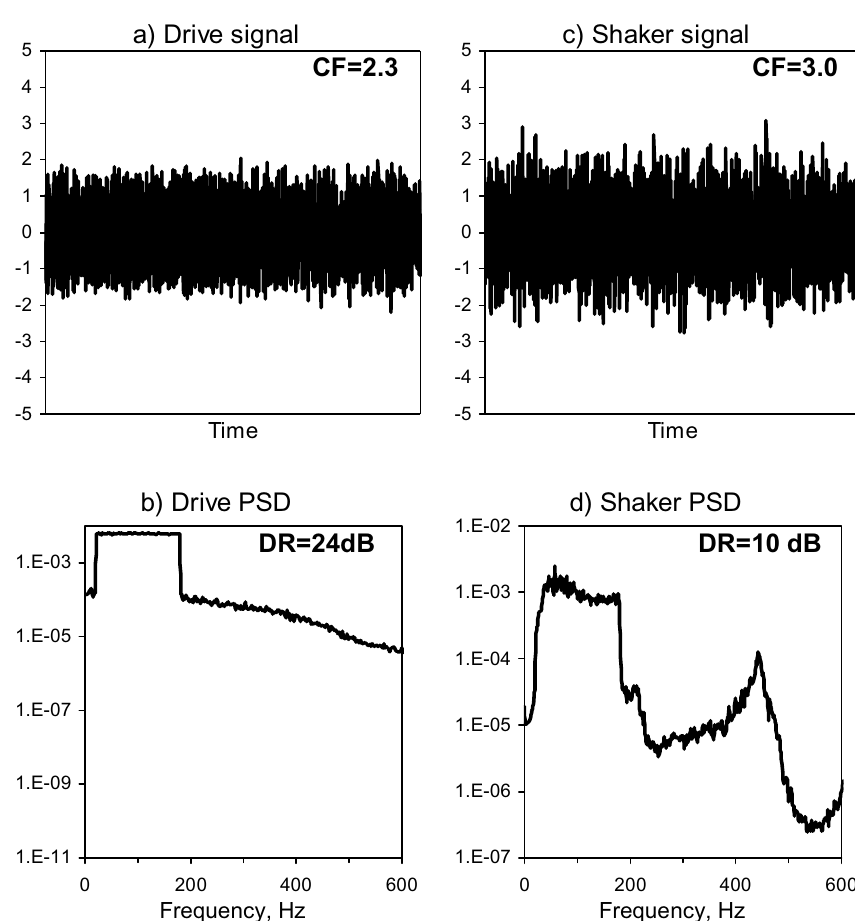
Fig. 4. Experimental results for non-Gaussian polynomial transform